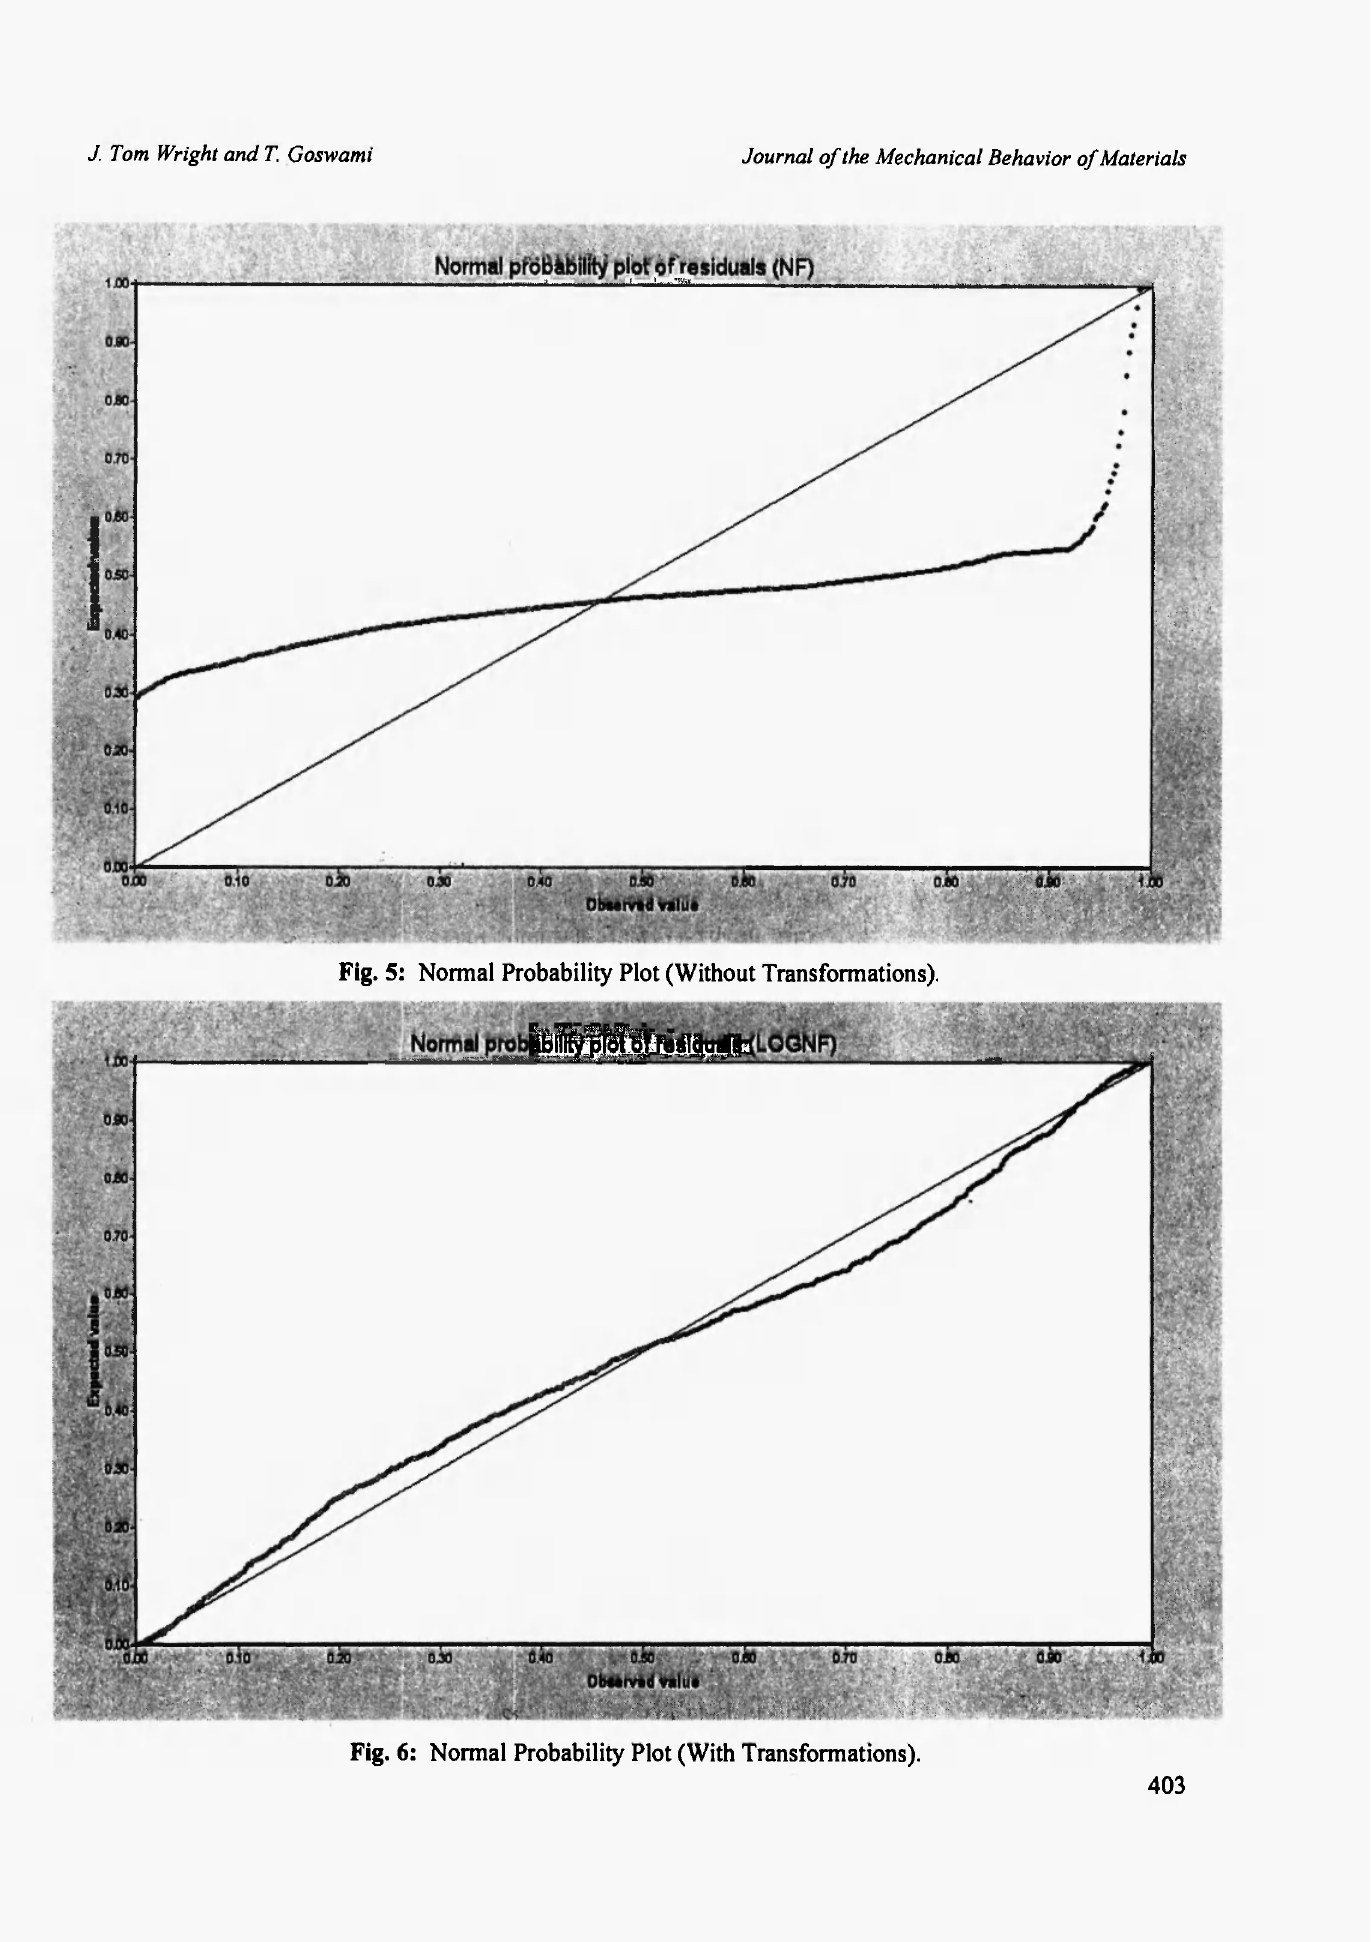
Fig. 6: Normal Probability Plot (With